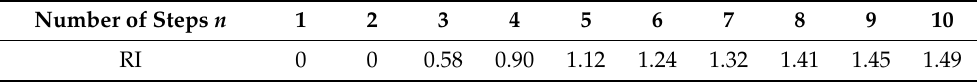
Table 5. Average random consistency index allocation